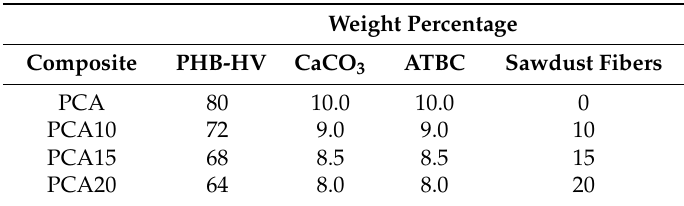
Table 3. Composite